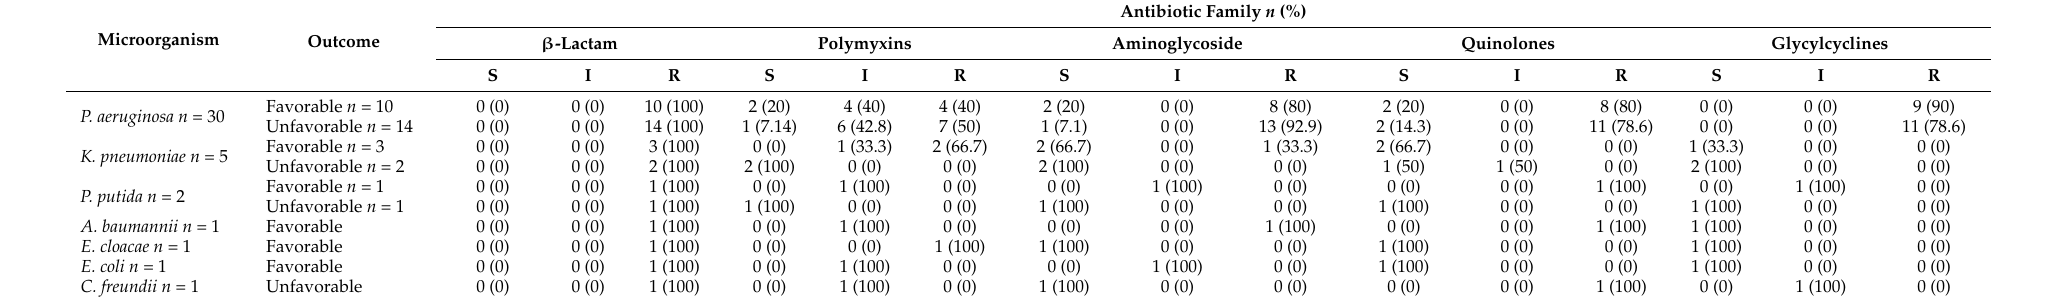
Table 2. Susceptibility profile of some microorganisms included in the study.